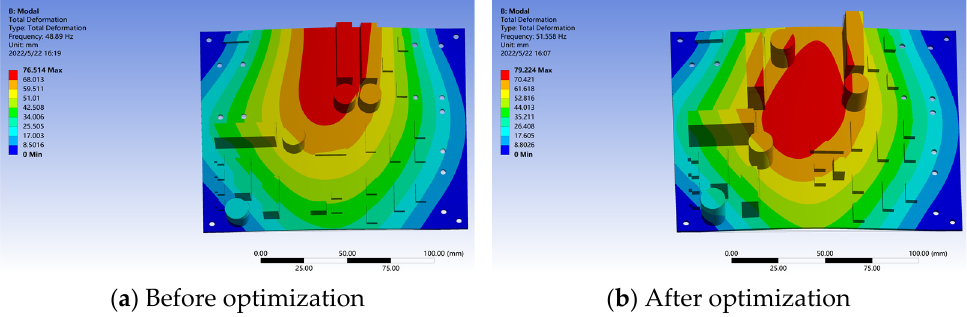
Figure 14. PCB first-order mode shape diagrams before and after optimization.